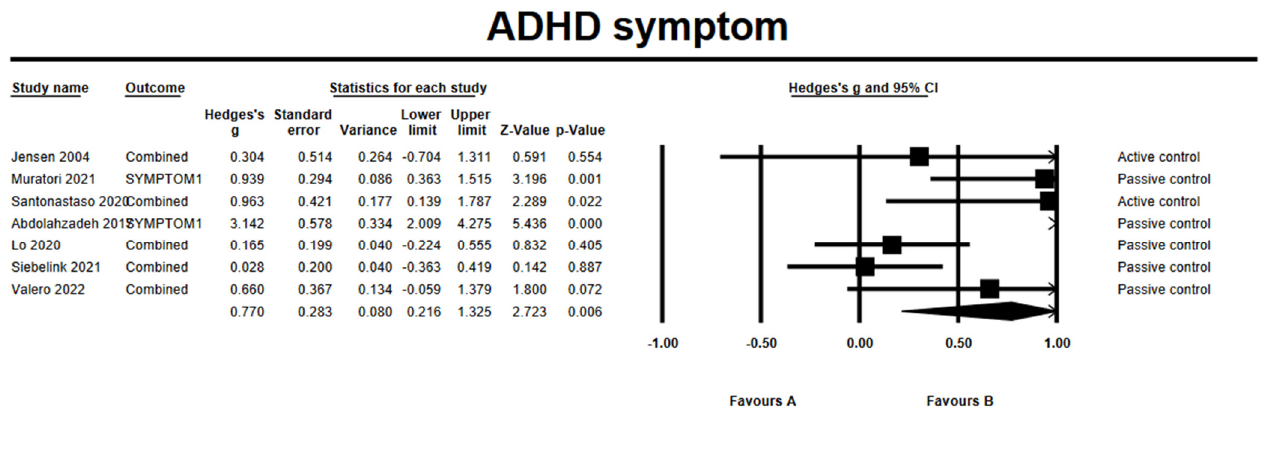
Table 2. Methodological quality assessment of included studies on the PEDro Scale.